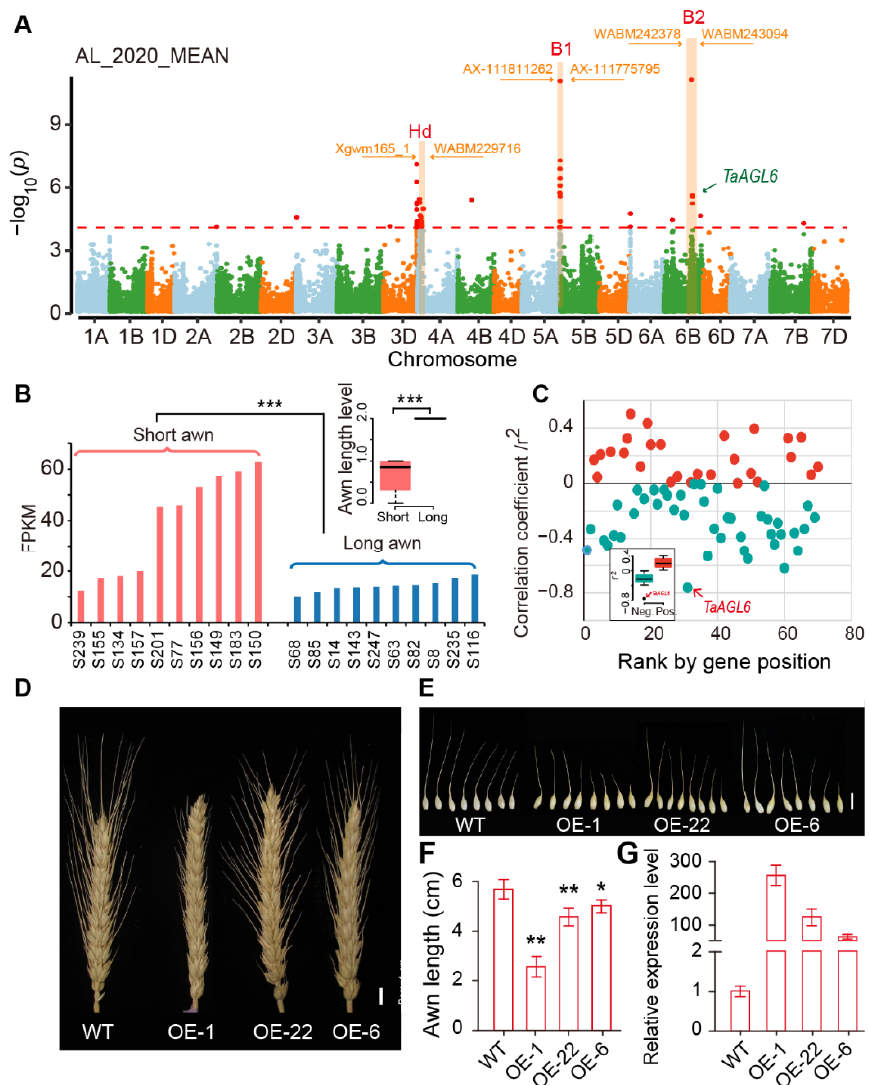
Figure 5. GWAS for wheat awn length and identification of TaAGL6 as a causal gene candidate for the B2 locus. ( A ) Whole genome Manhattan and QQ plots for loci significantly associated with awn length. Dashed line indicates the significance threshold ( − log 10 p = 4). The three orange shaded peaks were three awn-related loci Hd , B1 and B2 . ( B ) TaAGL6 showed significant differential expression (*** p < 0.001) between 10 long-awned accessions and 10 awnletted/awnless accessions. Correlation analysis between gene expression levels and awn length in 20 accessions with inflorescence RNA-seq data as in ( C ) showing TaAGL6 having the smallest negative coefficient (r 2 = − 0.78). ( D – G ) Over- expressing TaAGL6 in cv. “Fielder” led to awnletted spikes. OE-1, OE-22, and OE-5 are TaAGL6 overexpression lines. * p < 0.05, ** p <